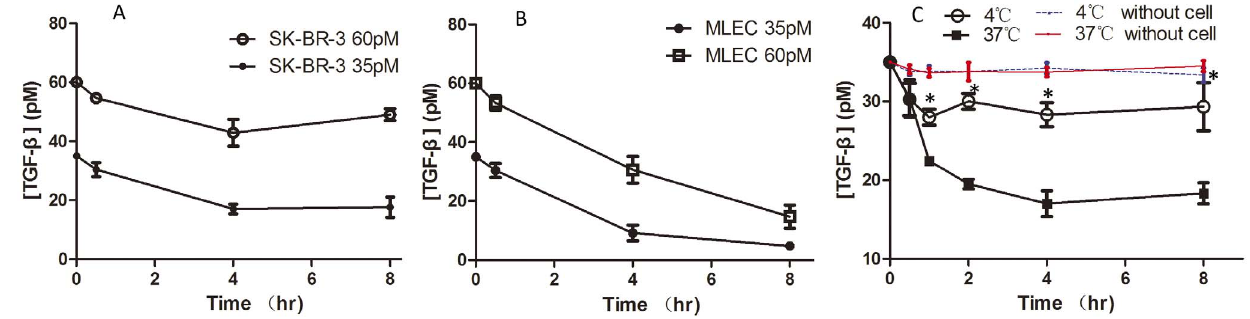
Figure 4. Time course curves of TGF- b depletion by SK-BR-3 and MLEC cells under different incubation conditions. SK-BR-3 and MLEC cells were incubated in condition medium containing 35 or 60 pM of TGF- b for up to 8 h and aliquots of the incubation medium were collected at different time points. The remaining TGF- b content in those samples was quantified by a TGF- b reporter assay. (A) Curves of TGF- b depletion in SK- BR-3 cells in the presence of TGF- b at 35 and 60 pM. (B) Curves of TGF- b depletion in MLEC cells in the presence of TGF- b at 35 and 60 pM. (C) Curves of TGF- b depletion in SK-BR-3 cells at 4 u C and 37 u C (35 pM TGF- b ). At 4 u C, endocytosis was stopped. Data are Means 6 SD of at least three independent experiments in each condition. * P , 0.05.(4 u C vs 37 u C)